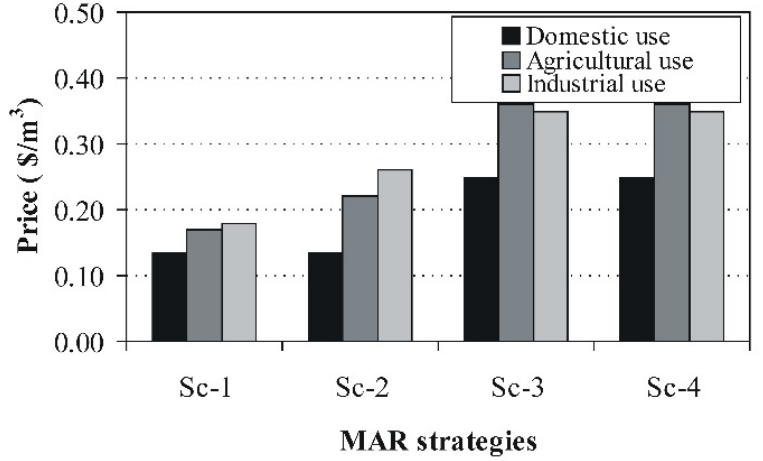
Figure 6. Willingness to pay of the respondents for the MAR strategies for different